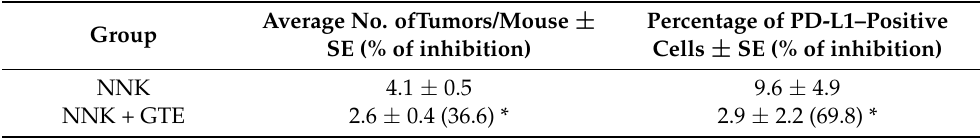
Table 1. Oral administration of GTE reduced average number of lung tumors and percentage of